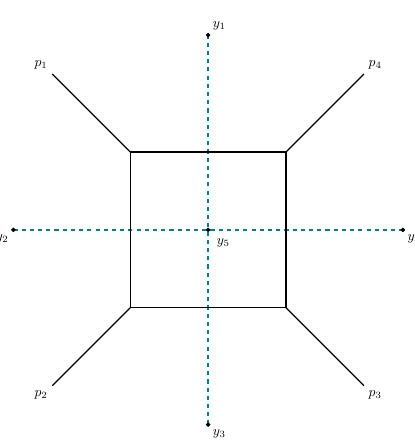
Figure 1. The Feynman diagram corresponding to the box topology with its dual. The momenta p i are all incoming. y i are dual variables in momentum